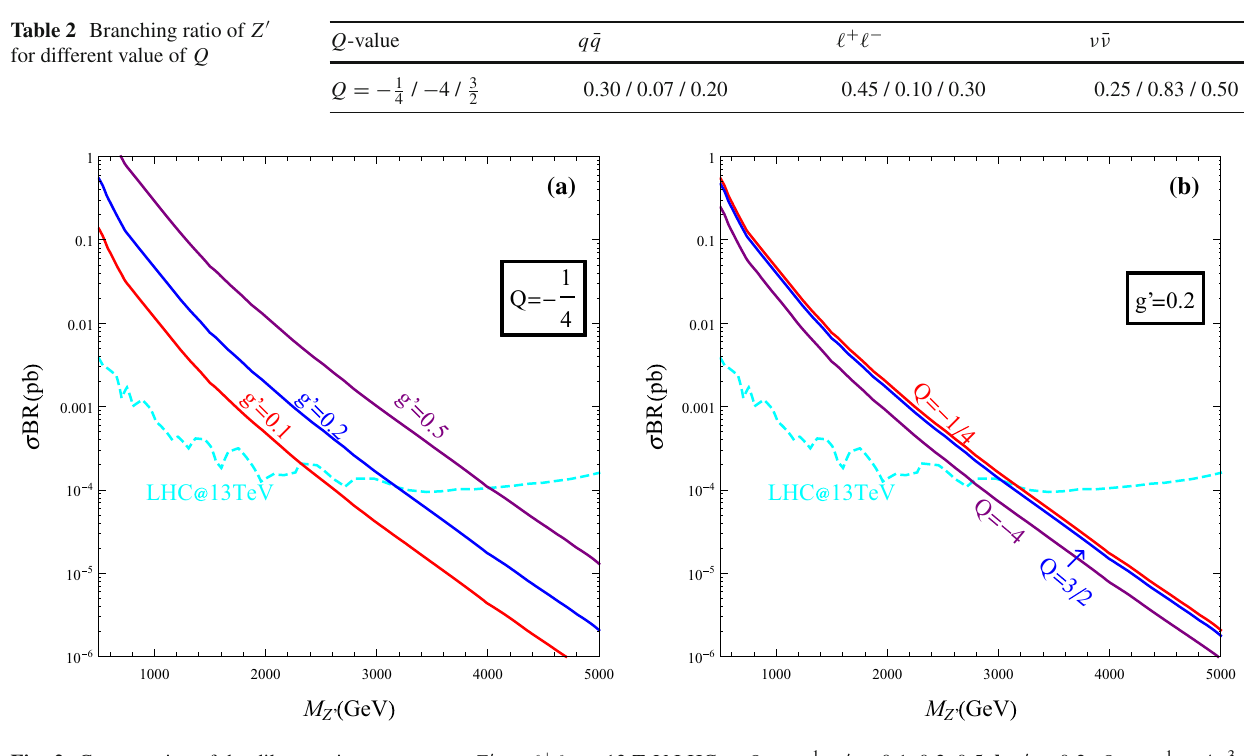
, g (cid:2) = 0 . 1 , 0 . 2 , 0 . 5. b g (cid:2) = 0 . 2, Q = − 1 4